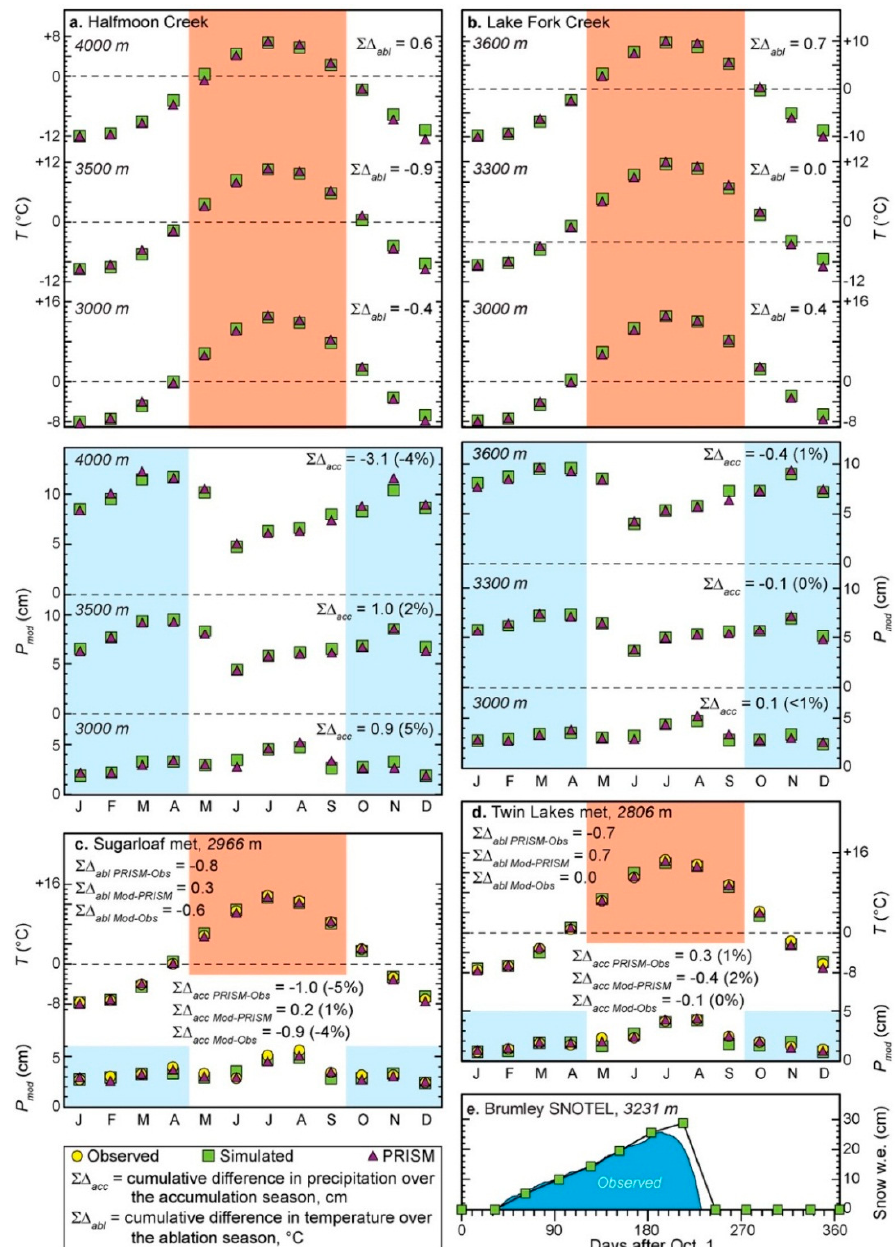
Figure 4. Examples of simulated modern temperatures T and precipitation P mod compared to the PRISM-derived values ( a and b ) and with T and P mod recorded at meteorological stations ( c and d ). ( e ) Comparison of simulated snowpack evolution and that observed (1981–2010 normal) at the Brumley SNOTEL site. Shaded portions in a–d highlight the critical ablation (orange) and accumulation seasons (blue).